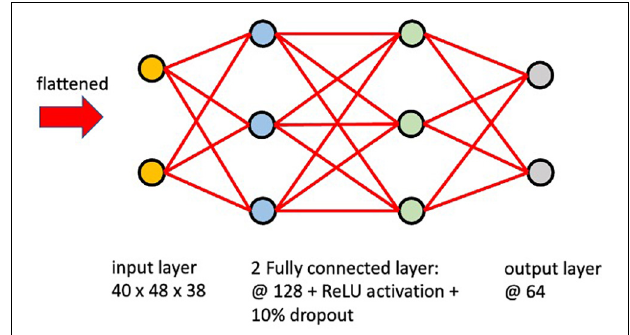
FIGURE 2 | Network architecture of a single encoder.